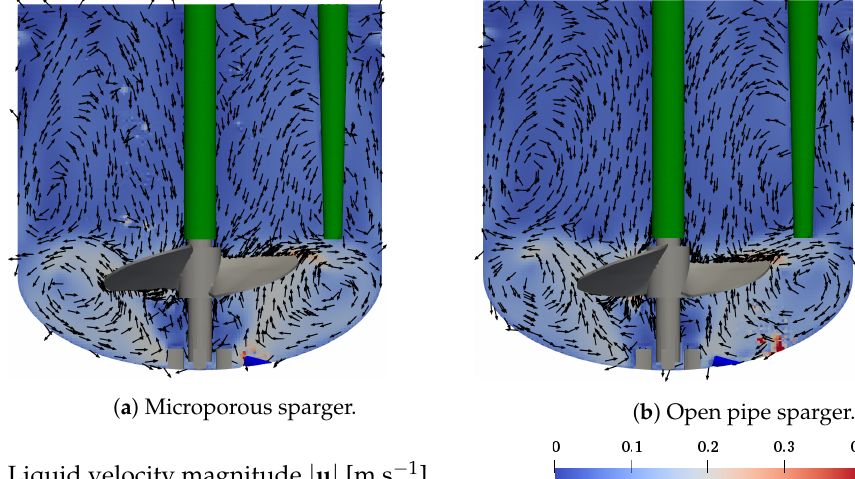
Figure 3. Liquid flow field in the x - z plane through the center of the vessel. Arrows show the velocity in x - z -direction. Conditions: V = 1.7 L, n = 100 rpm, and Q = 50 mL min − 1 . ( a ) Microporous sparger (condition #4) and ( b ) the open pipe sparger (condition